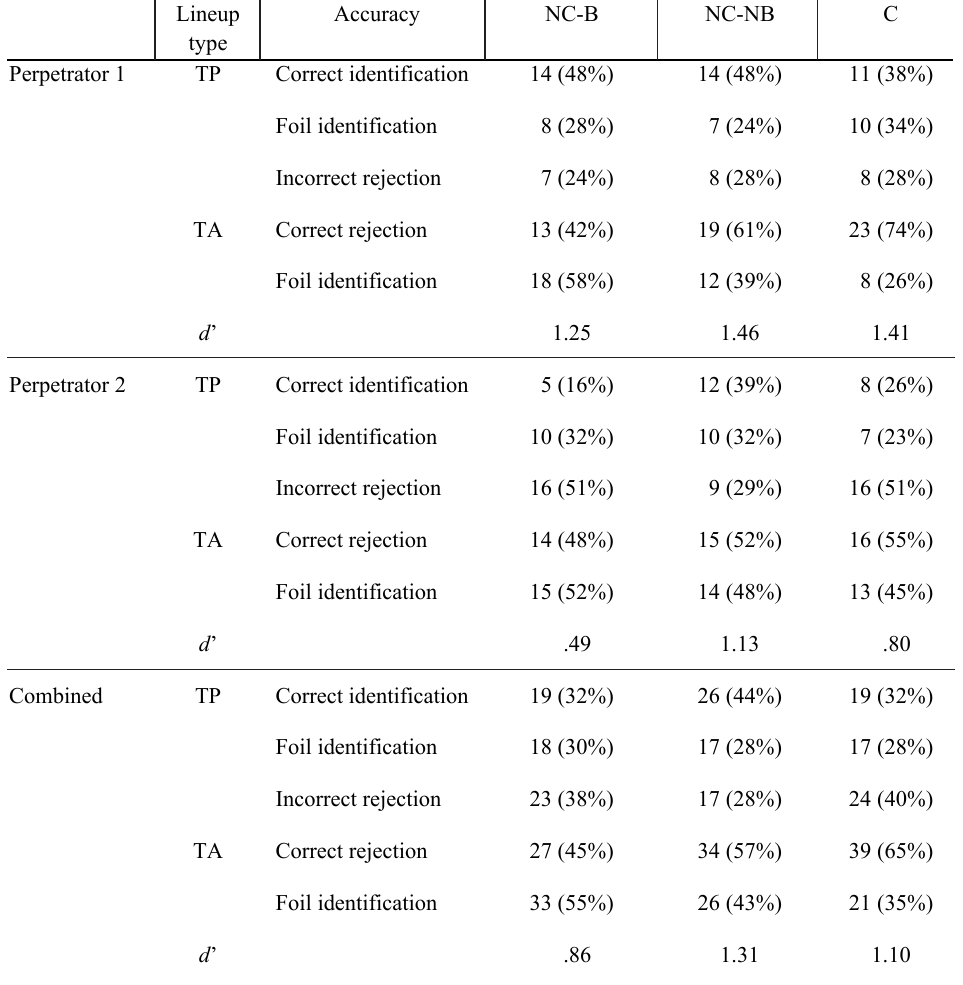
Table 2. Identification accuracy and discriminability scores of Perpetrators 1 and 2 in TP and TA